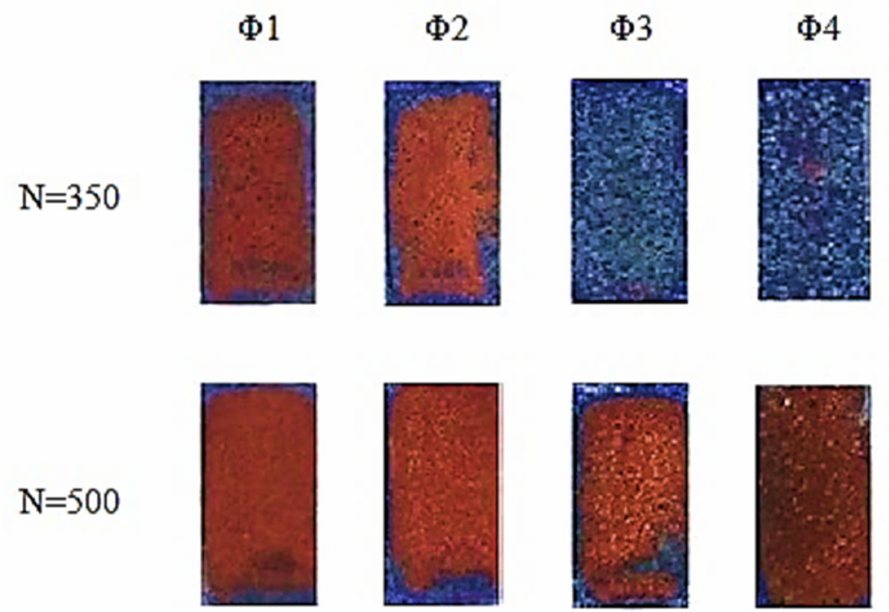
Figure 4. Coatings containing 15 wt.% of [Cu(L-tyr) 2 ] n and 10 wt.% of glass microspheres Φ 1 , Φ 2 , Φ 3 and Φ 4 , irradiated with 350 or 500 laser pulses (N) with a fluence of 100 mJ/cm 2 , after electroless